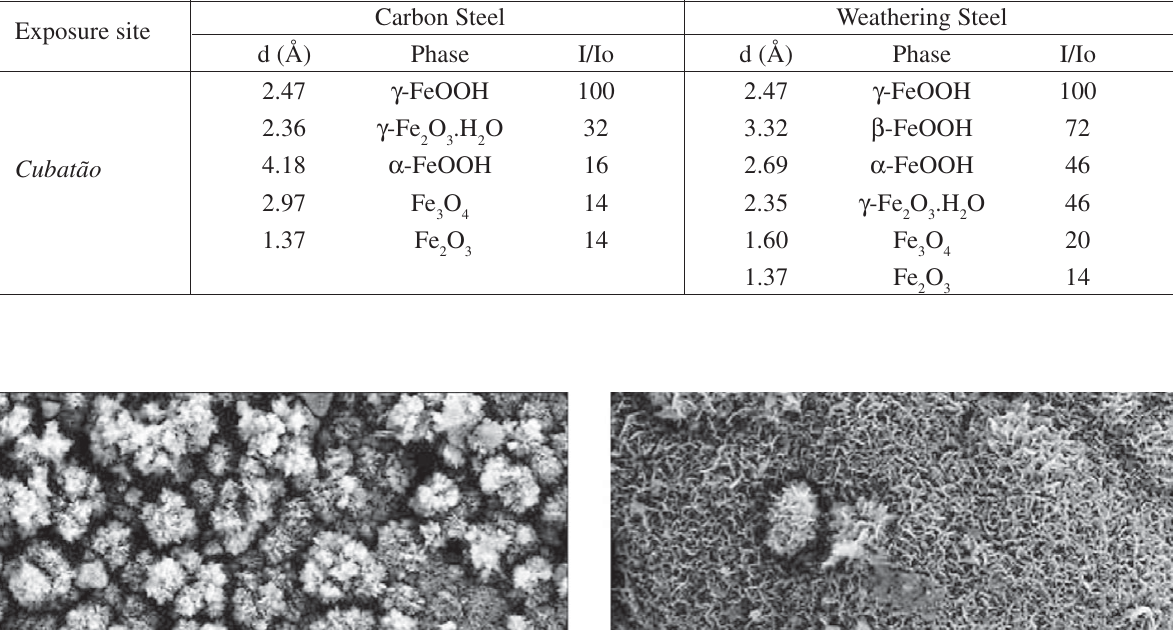
Table 2. X-ray diffraction data for carbon steel and weathering steel specimens exposed for three months at Cubatão site. Exposure site